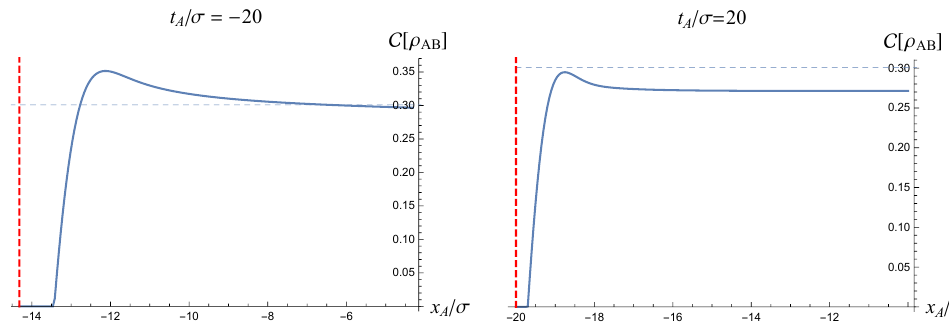
Figure 3 . Concurrence as a function of position of detector A for various (cid:12)xed detector separations (cid:1) x , with (cid:20) = 0 : 5 ; (cid:10) = 1 ; (cid:27) = 1 for CW mirror (in red at time t = t A = t B when the switching function is peaked). Note that x A =(cid:27); (cid:10) (cid:27); (cid:20)(cid:27) are dimensionless and numerically equal to x A ; (cid:20); (cid:10) since (cid:27) = 1. Left: t A =(cid:27) = (cid:0) 20. Right: t A =(cid:27) = 20. The entanglement extracted by the detectors are strictly lower than free space, and in both case there is a (cid:12)nite region near the mirror where entanglement extraction is